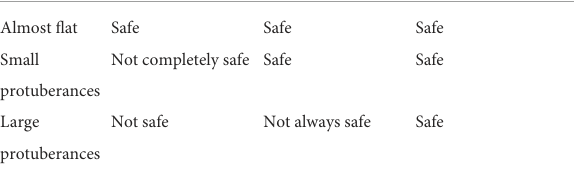
TABLE 2 Comparison between behavior for different thresholds for different types of seafloor. Type